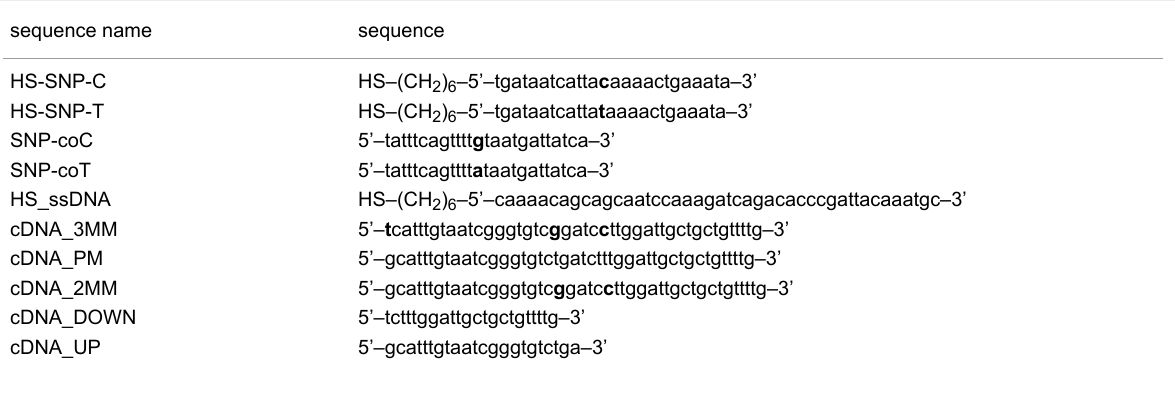
Table 1: List of the sequences used for the AFM and EIS experiments. The position of the mismatches are typeset in bold. sequence